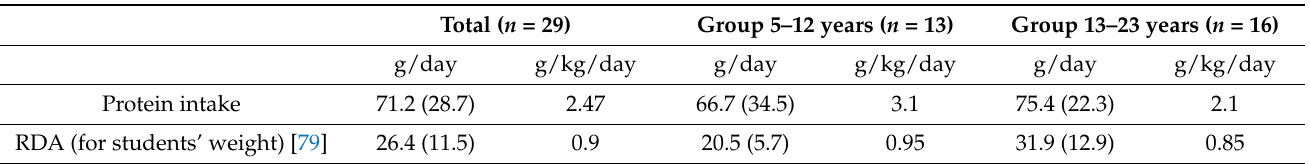
Figure 7. Relationship between ( a ) student protein intake (g) and weight, and ( b ) protein intake (g) and age compared to recommendations of protein intake ( n = 29). Table 3. Comparison of the daily protein intake of the students with the recommended dietary allowance (RDA) according to age group, mean (SD).